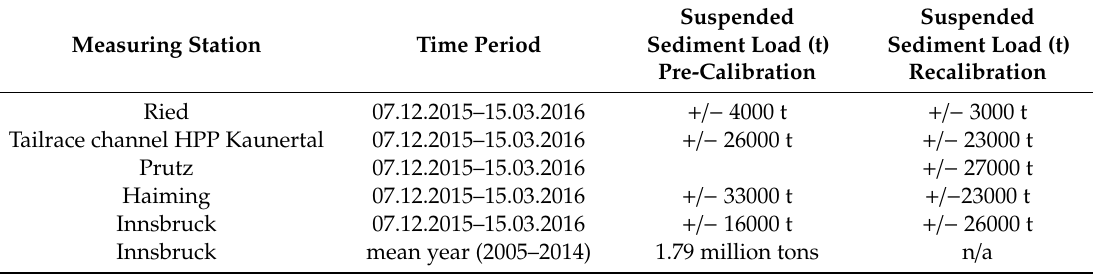
Table 2. Suspended sediment loads for the time period 07 December, 2015 – 14 March, 2016 at the measuring stations Ried, tailrace channel HPP Kaunertal, Prutz, Haiming, and Innsbruck.